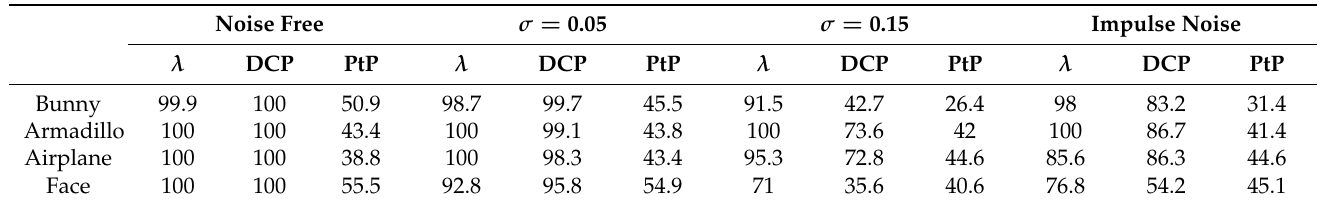
Table 5. Average convergence rates of the λ -ICP, DCP, PtP algorithms in percent for different cases. Noise Free σ = 0.05 σ = 0.15 Impulse Noise λ DCP PtP λ DCP